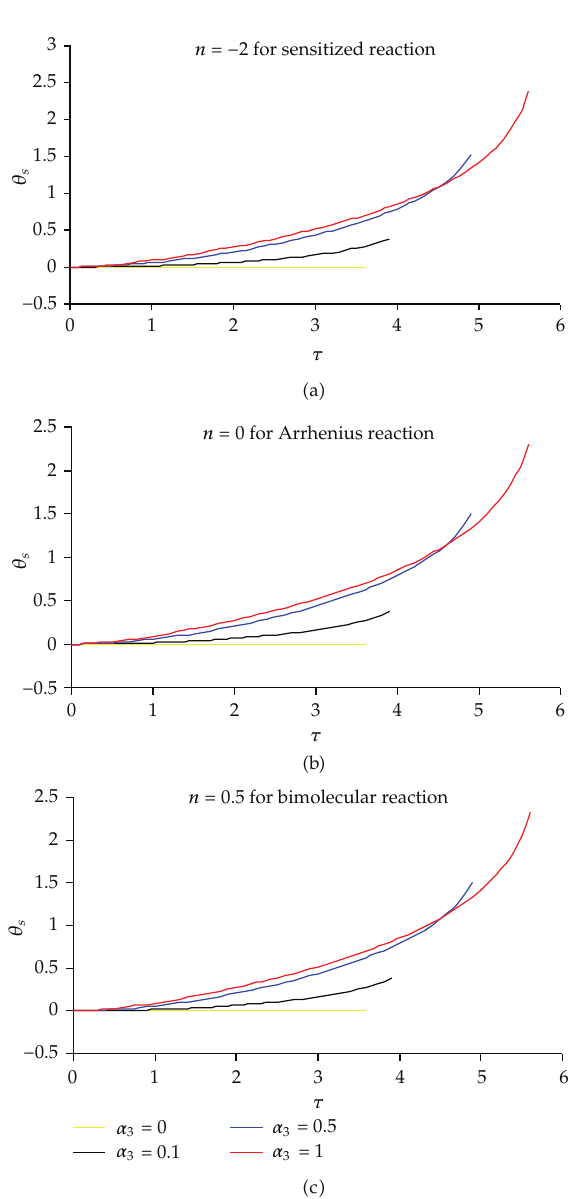
Figure 2: Variation of dimensionless solid particle temperature with interphase heat exchange parameters when n (cid:7) {− 2 , 0 , 0 . 5 }